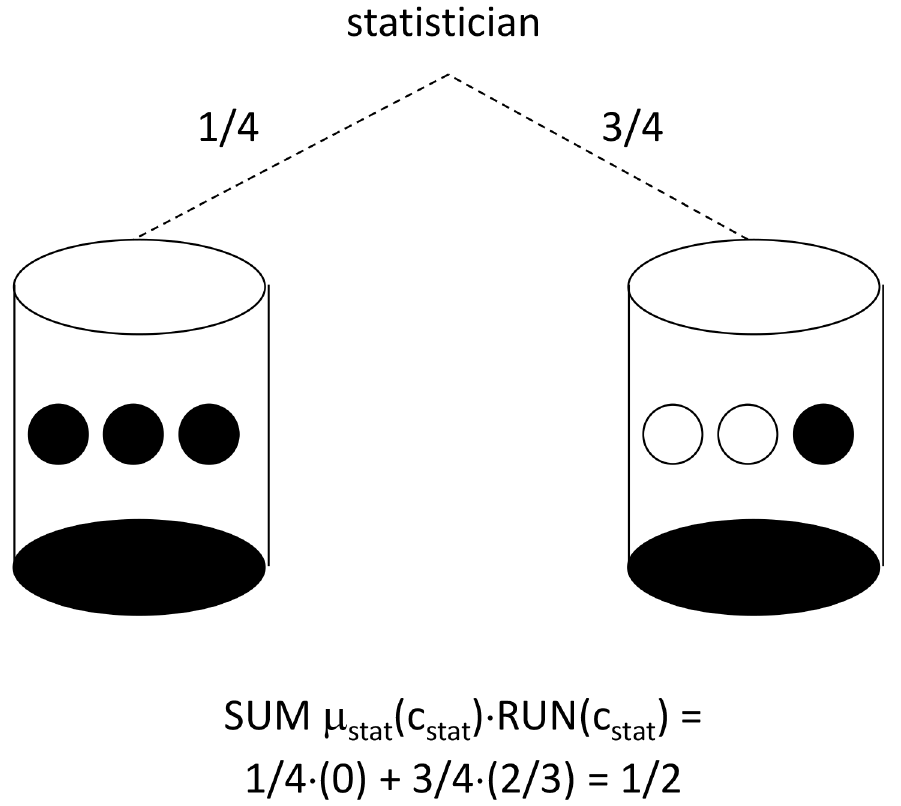
Fig 1. Urn Design for Run-Reversal Equilibrium with 3 Clinics. An urn is selected according to the probabilities shown, and then balls are drawn without replacement until the urn is empty. A run in treatment imbalance is assigned for a clinic when a white ball is drawn. A reversal in treatment imbalance is assigned for a clinic when a black ball is